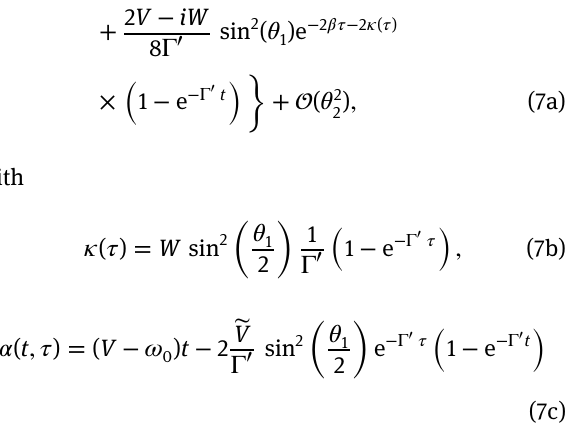
̃ and V = V − iW ∕ 2, which combines local field and EID in one complex quantity. The pump-probe polarization p consists of two parts: The first term in the curly brackets stems from the linear polarization generated by the sec- ond pulse which automatically carries the phase 𝜙 also appears in the pure 2LS without local field and